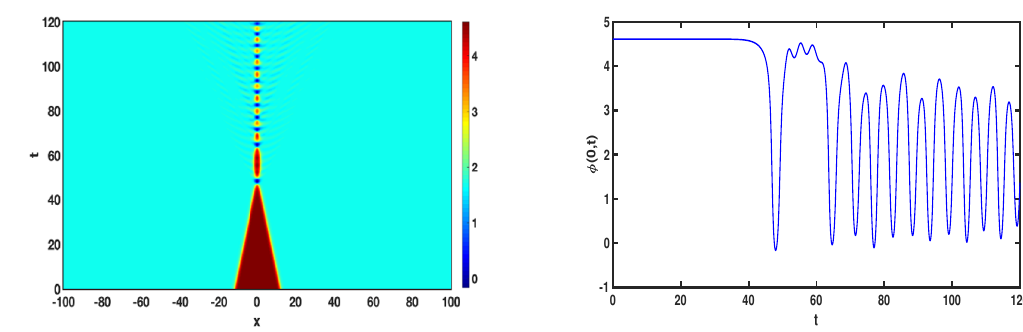
Figure 18 . Small kink-antikink collision, producing a bion state: r = 0 . 1, v = 0 . 24.